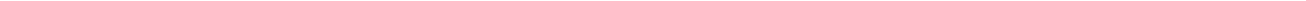
NATURE COMMUNICATIONS|7:13708|DOI: